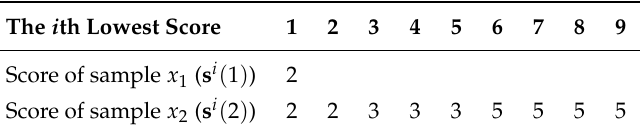
Table 3. The scores assigned by the panelists in Example 2.